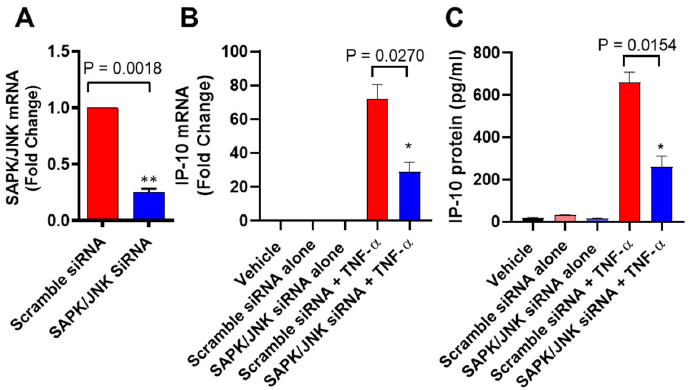
Figure 3. TNF- α -induced IP-10 expression is attenuated in JNK-deficient cells. MCF-7 cells were transfected with either JNK siRNA (20 nM) or scrambled siRNA (20 nM), as described in Materials and Methods. ( A ) After 36 h, real-time RT-PCR was performed to measure JNK mRNA expression. ( B , C ) MCF-7 sells transfected with JNK siRNA or scrambled siRNA were incubated with TNF-α (20 ng/mL) for 24 h. Cells and supernatants were collected, and IP-10 mRNA and protein were measured by real-time RT-PCR and ELISA, respectively. All data are expressed as mean ± SEM ( n = 3). * p < 0.05, ** p < 0.01.